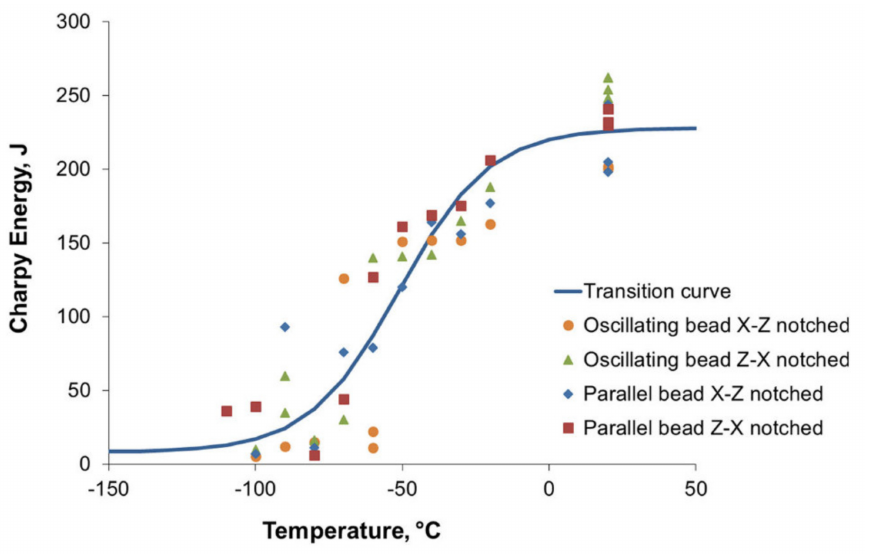
Figure 19. Charpy impact data and ductile-to-brittle transition curve fit for carbon steel arc-AM specimens